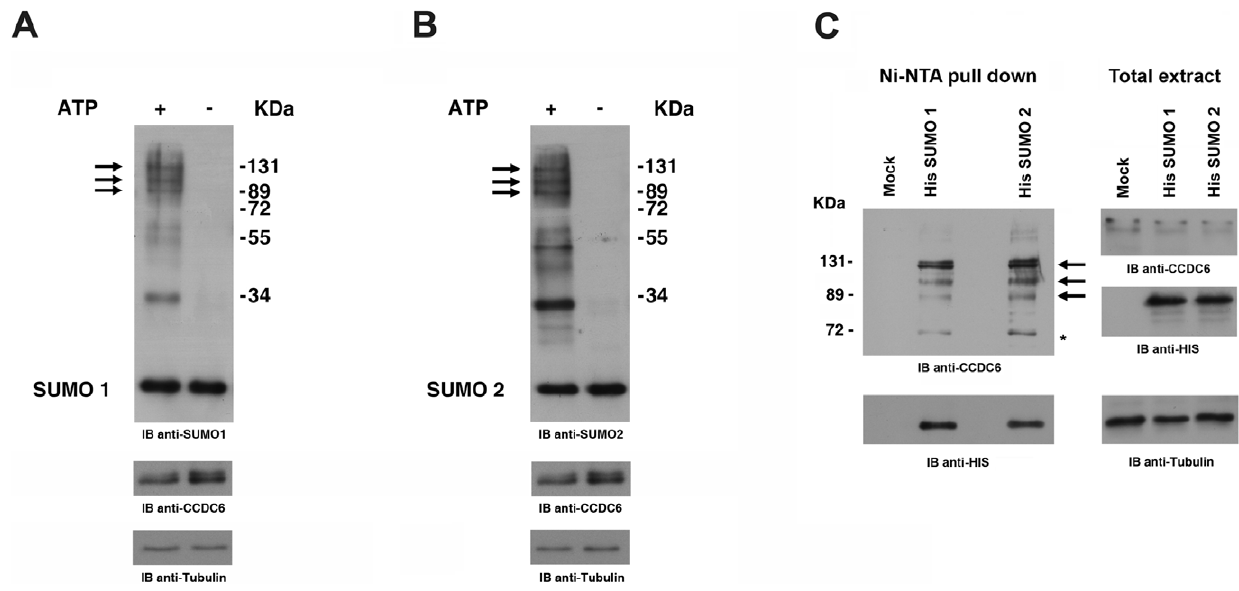
Figure 1. CCDC6 is modified by SUMO1 and SUMO2 in vitro. A) and B): 200 nM of CCDC6 were incubated with recombinant E1, E2 and either SUMO1 or SUMO2 in presence of Mg-ATP solution. In control reactions the Mg-ATP was omitted. Detection of SUMO1- and SUMO2- CCDC6 conjugates at western blot are indicated by arrows. Immunoblot anti-CCDC6 and anti-Tubulin are shown as loading controls. C) Endogenous CCDC6 is conjugated to SUMO1 and to SUMO2: HEK293 cells were transfected with plasmids expressing His-tagged SUMO2 or SUMO1. SUMO-conjugated proteins were isolated by nickel affinity chromatography and separated by SDS-PAGE. Endogenous CCDC6 was detected by immunoblotting using anti-CCDC6 antibody (top panel). Star (*) indicates the unsumoylated CCDC6 bands. The His SUMO1 and His-SUMO2 were revealed by anti-His hybridization. The expression of CCDC6 in crude extract was also detected using an anti-CCDC6 antibody (right panel).The filter was stripped and reprobed using anti-his antibody to assess comparable amount of His-SUMO proteins. The anti-tubulin is shown as loading control. Mock in C indicates mock transfection control.